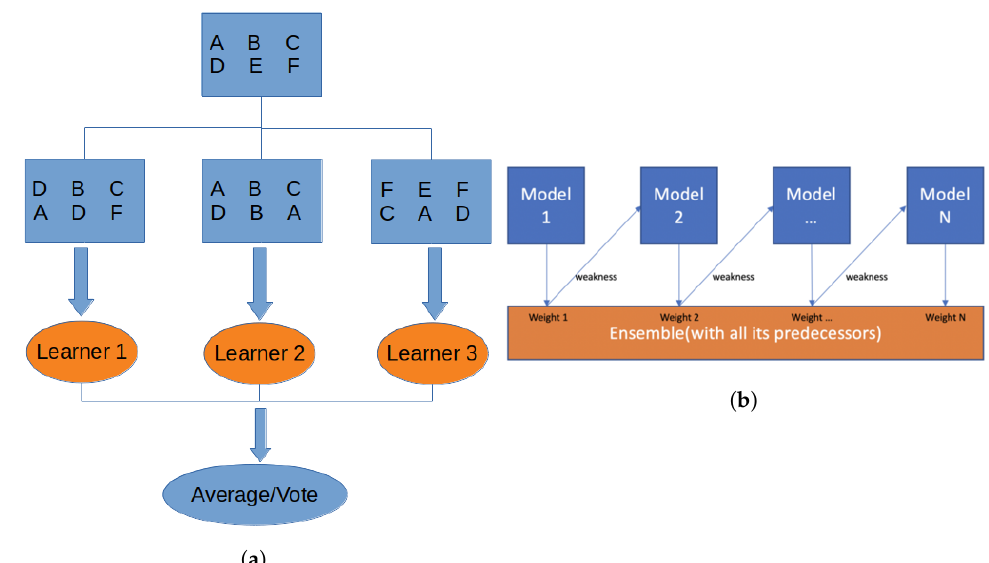
Figure 3. Schematics illustrating the various ensemble model approaches. ( a ) Bagging, ( b )